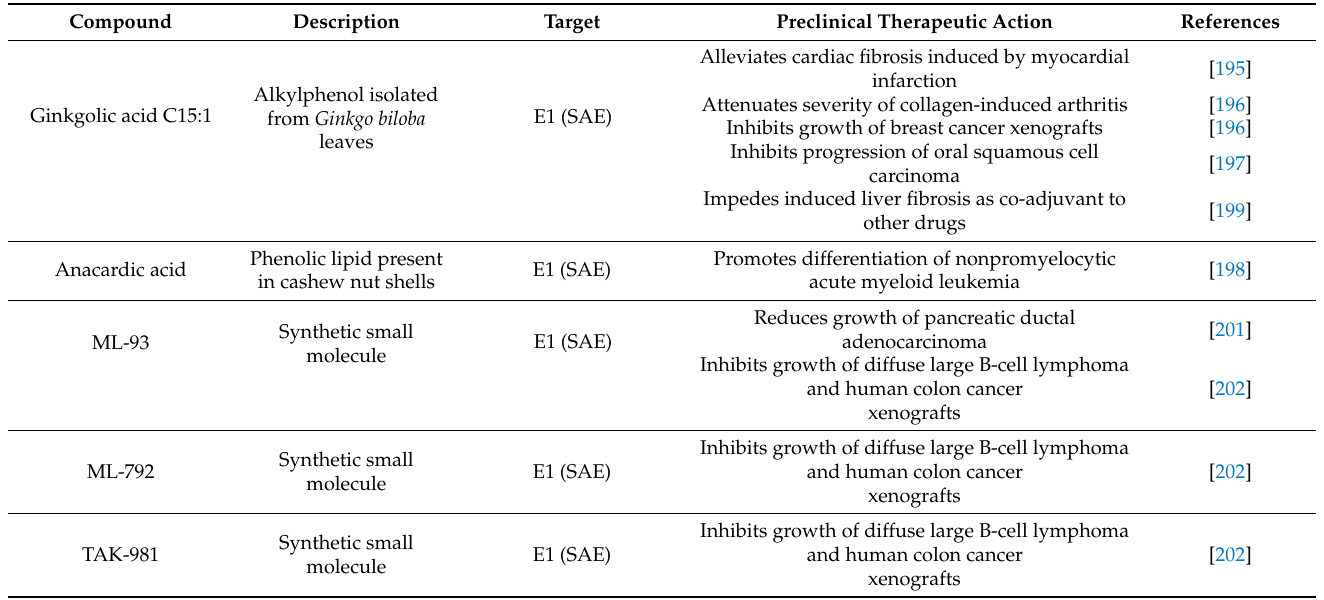
Table 1. Inhibitors of SUMOylation enzymes with therapeutic properties in preclinical animal